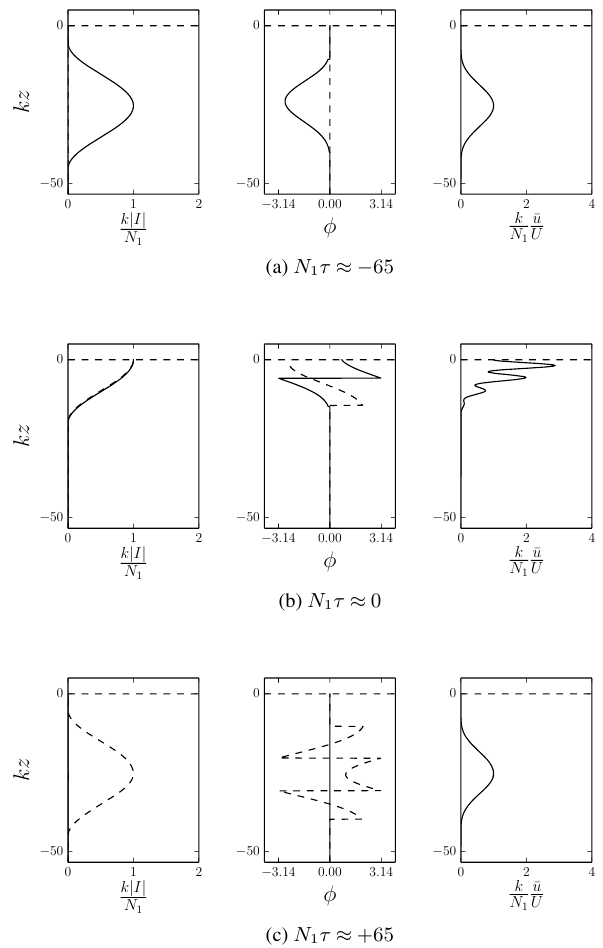
Figure 19. Vertical profiles of the wave magnitude (left panel), phase (center panel), and mean flow (right panel) at three time val- √ ues with a rigid lid, with n 1 /k = 1 / 2, (cid:15) = 0.025, and α = 0.1. The line conventions are the same as Fig.